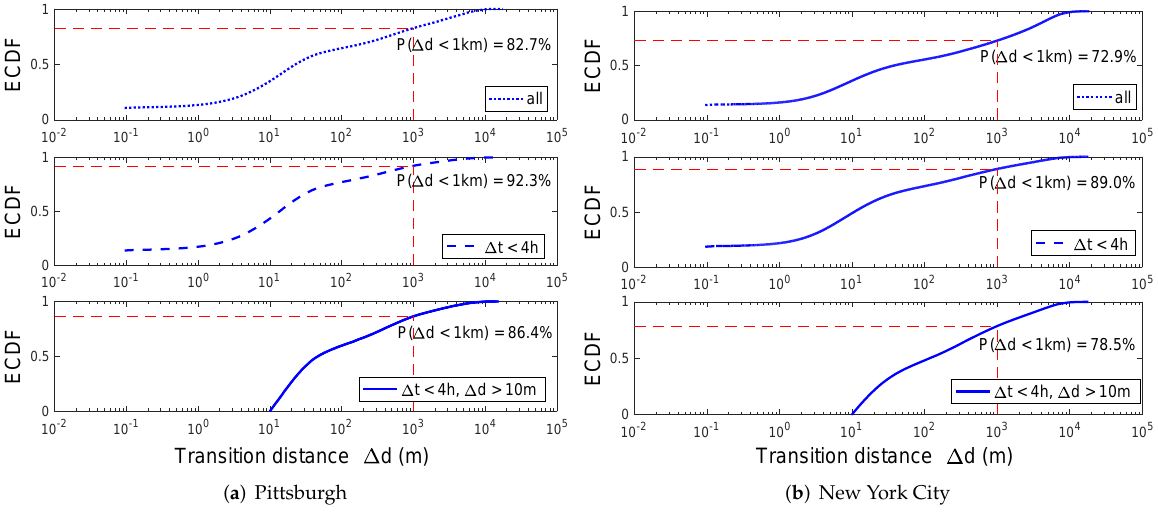
Figure 3. The Empirical Cumulative Distribution Function of transition distance under different parameters. The top figure includes all transitions, the one in the middle keeps transitions with time interval ∆ t < 4 h, while the bottom as the setting we select for our later analysis only keeps transitions with time interval ∆ t < 4 h and transition distance ∆ d > 10 m. Our parameter selection captures a majority of the transitions, i.e., 86.4% for Pittsburgh and 78.5% for New York